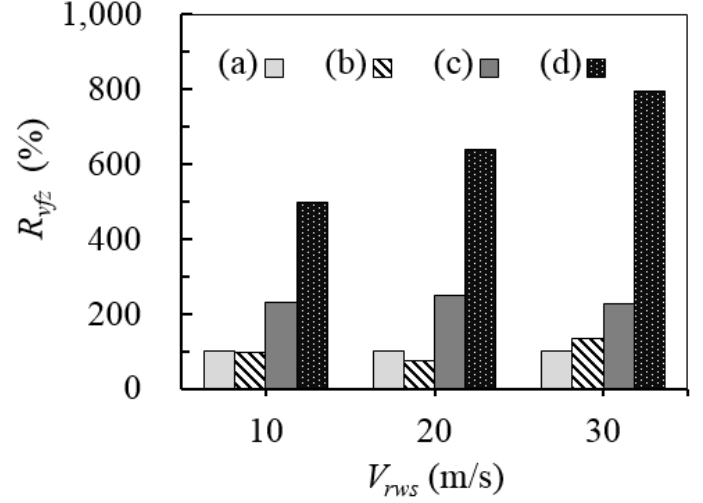
Figure 9. Relative volume ratio ( R vfz ) based on the relative wind speed ( V rws ) for four scenarios, based on selection of emitting vent masts of the original type of outlet; ( a ) emission from the first vent mast alone; ( b ) emission from the second vent mast alone; ( c ) emissions from both of the first and second vent masts; and ( d ) emissions from all of the four vent masts.